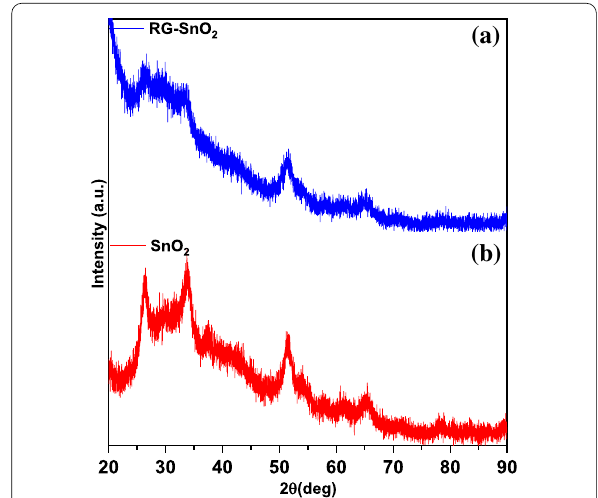
Fig. 1 Crystal structure and phase purity analysis. Powder X‑ray diffraction pattern of the as‑prepared a SnO 2 nanospheres and b reduced graphene oxide incorporated SnO 2 nanospheres